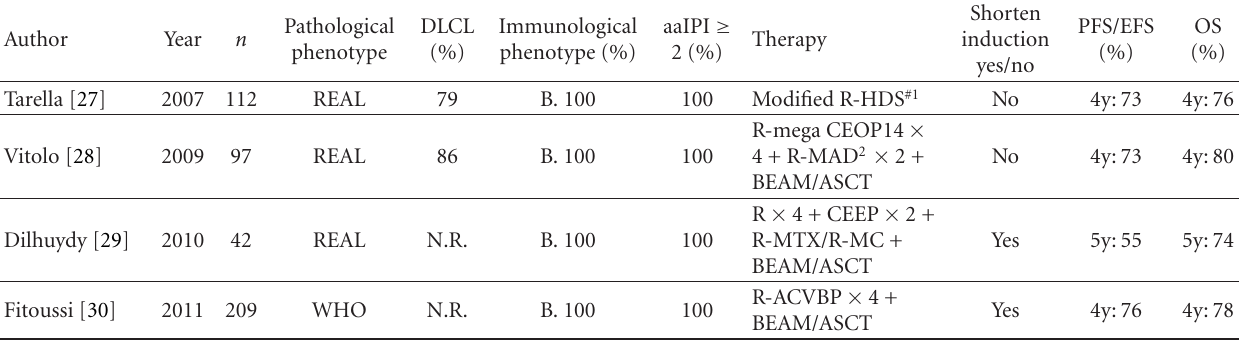
Table 3: Studies of HDT/ASCT in unfavorable DLBCL